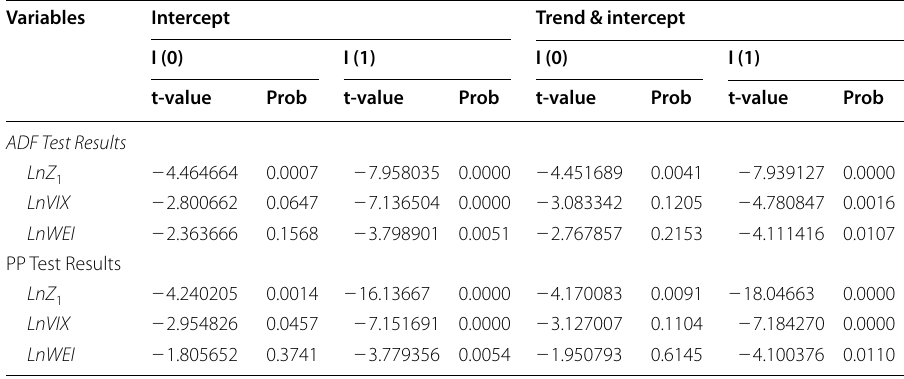
Table 9 Vector autoregressive model of LnVIX and LnWEI with X